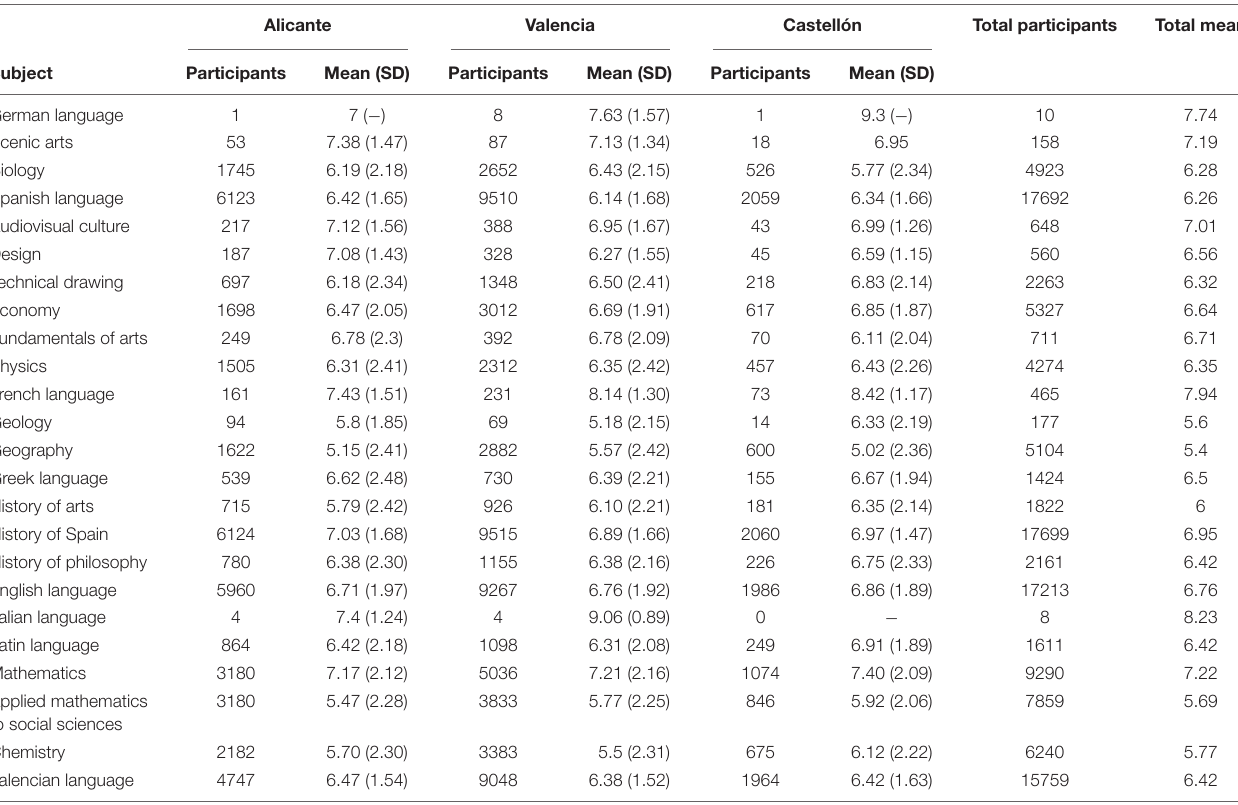
TABLE 1 | Examination grades by province: means and standard